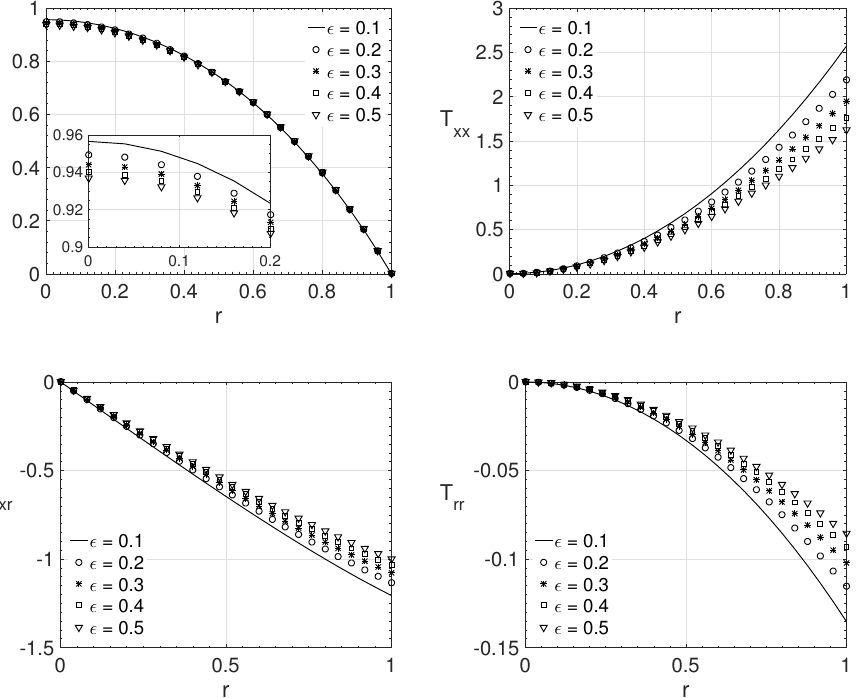
Figure 6. (cid:101) influence on the radial variation r of the streamwise velocity component u and the extra-stress tensor components T xx , T xr and T rr . Dimensionless parameters: Re = 1, β = 0.2, ξ = 0.1 and Wi =